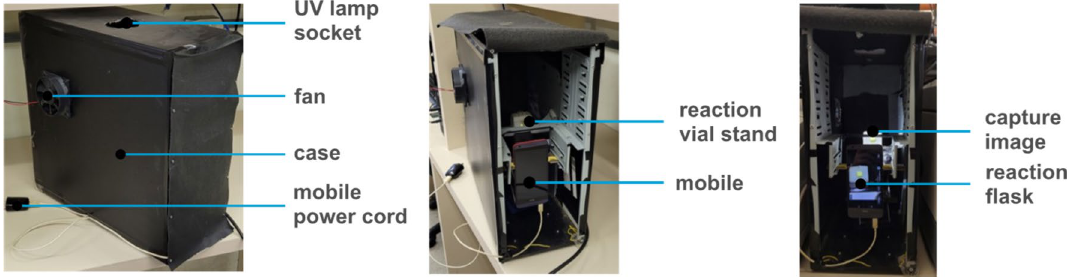
Figure 7. The exterior (left) and interior (middle and right) of the computer case used for capturing